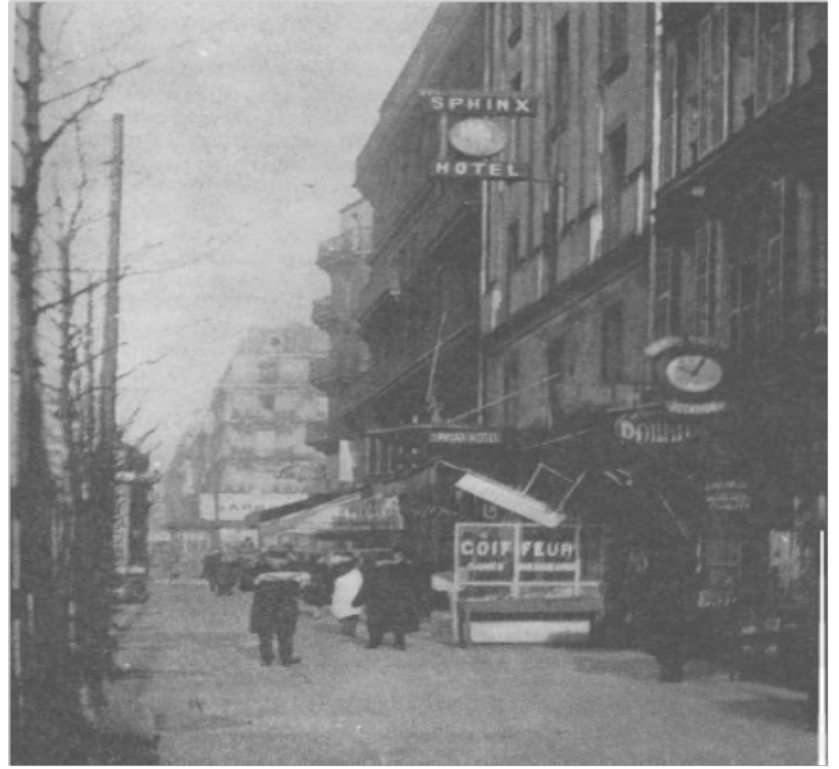
Figure 6. Boiffard, J. A Boulevard Magenta Devant “Le Sphinx Hotel” © Mme. Denise Boiffard in Nadja